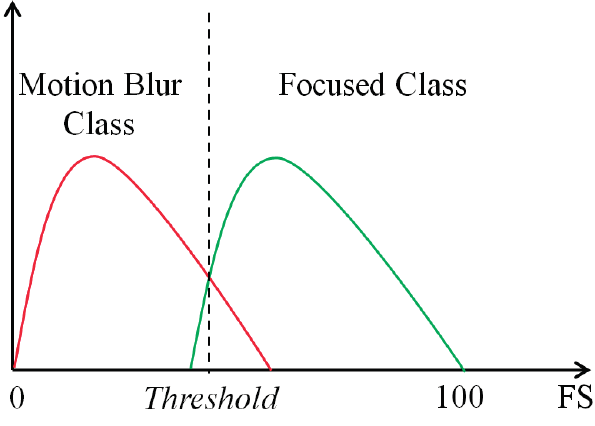
Figure 12. Classification of focused and motion blur classes using proposed focus score measurement